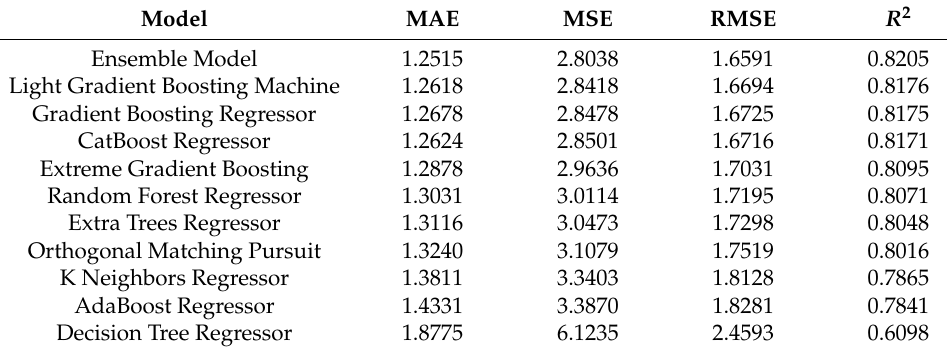
Table 4. Model performance for Maximum Temperature